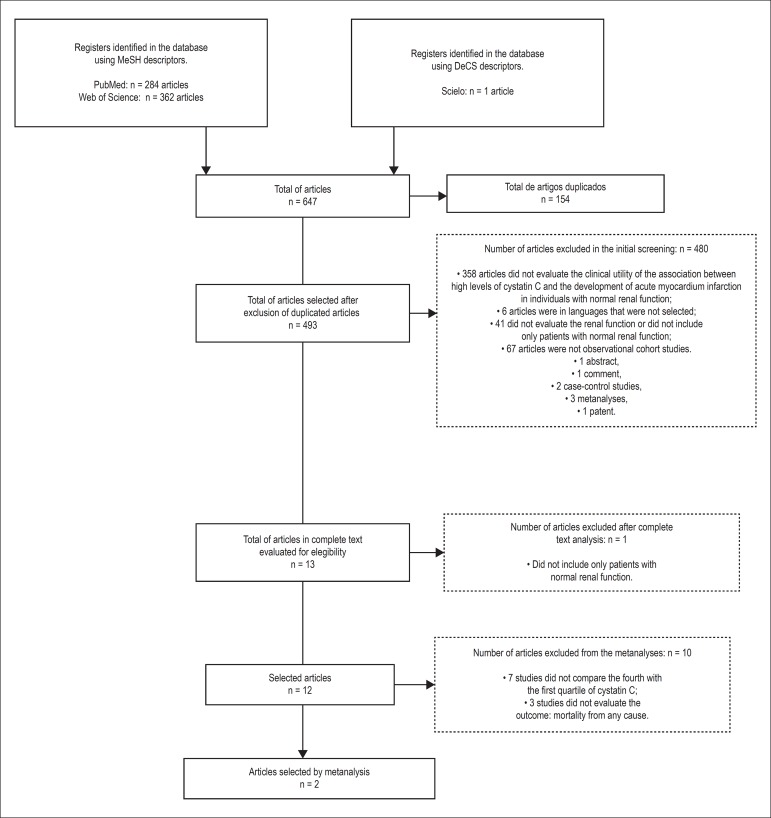
Flow chart of the articles selected for review, according to the
elegibility criteria used in the study.